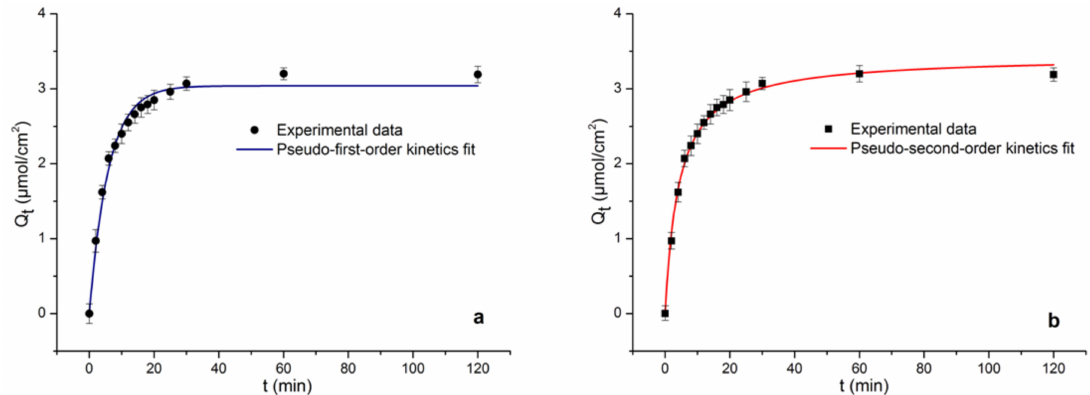
Figure 8. Fitted curve of Pseudo first order kinetic adsorption model ( a ) and fitted curve of Pseudo second order kinetic adsorption model ( b ) of ECB-MICMs.